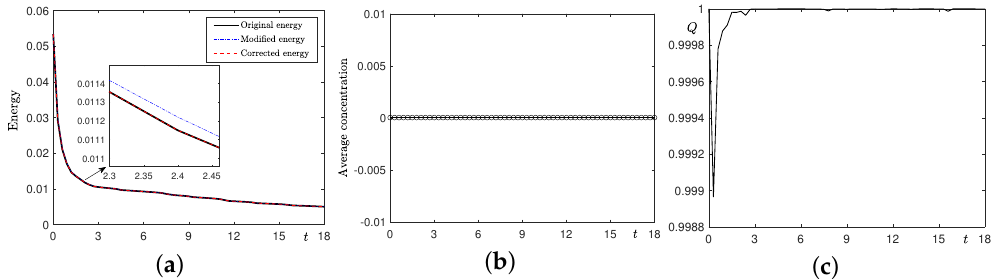
Figure 7. Evolutions of energy curves, average concentration, and Q n are plotted in ( a – c ),